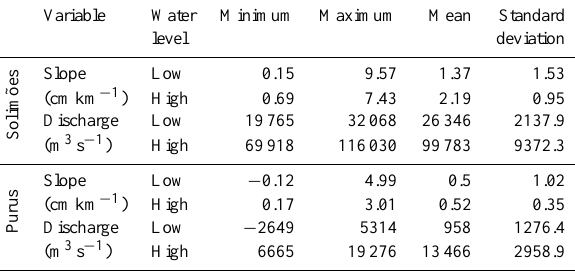
Table 1. Summary of along-channel variability in modelled water- surface slope and channel discharge at low and high